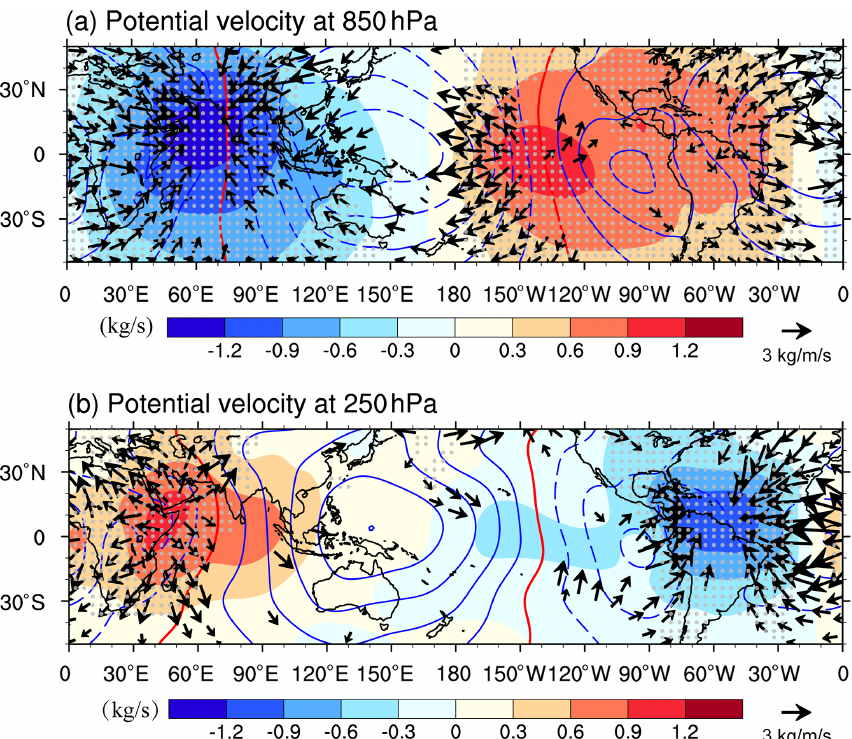
Figure 12. Changes in the potential function of zonal wind V Z at (a) 850hPa and (b) 250hPa (shading; in kgs − 1 ), corresponding to the divergent mode of the wind field (vectors; in kgm − 1 s − 1 ). V Z is decomposed from the 3P-DGAC method. The contours represent the climate mean of the potential function for the PI simulation. Solid curves indicate positive values, and dashed curves indicate negative values. Red solid curves represent zero values. The vectors and stippled regions are where at least 10 of 13 simulations in the model group agree on the ensemble